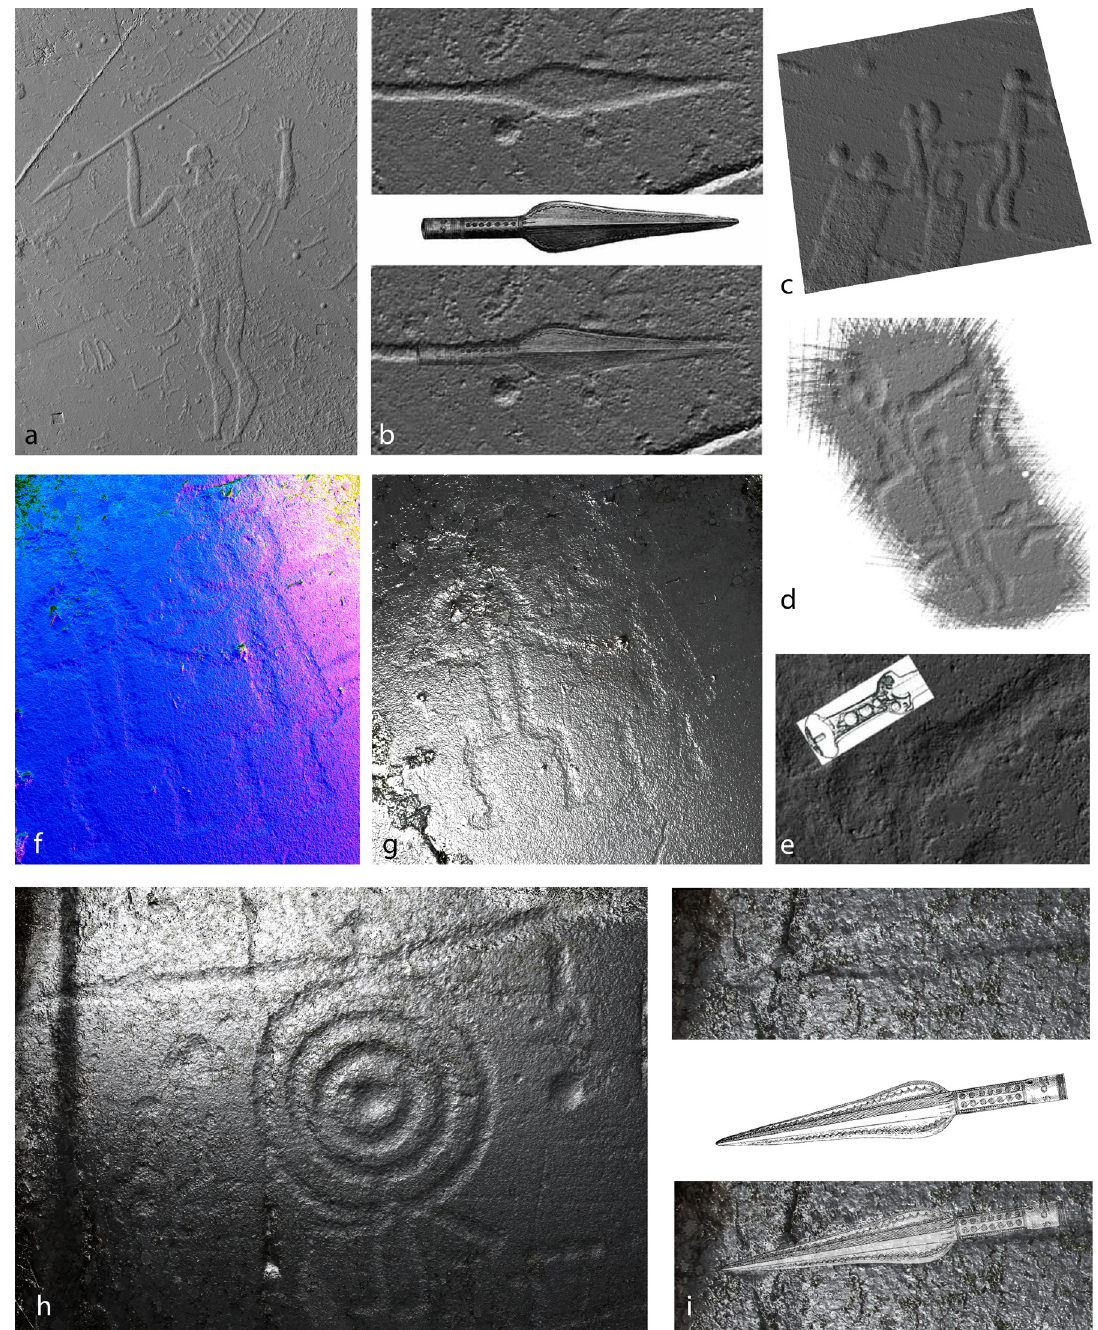
Figure 6. a. SfM of the spearman in Litsleby, RAÄ Tanum 75:1 by SHFA; b. Comparison of the spear point in Litsleby with a Valsømagle spear from Falköping (Bertilsson, 2015); c. SfM of warriors on the Fossum, RAÄ Tanum 255:1 by RP; d. Handyscan 700 scan by Länstyrelsen i Västra Götland; e. comparison with a flange hilted sword (Ling & Bertilsson, 2016); f. RTI of the two warriors with knees in Finntorp by RP & CH, normals visualized in RTIViewer and enhanced using the DStretch in ImageJ; g. RTI of the two warriors with knees, lighting adjusted to make the feet that form the knees visible on the right figure, specular enhancement filter; h. RTI of the spear man in Finntorp by RP & CH; i. Comparison of the spear point in Finntorp with a Valsø- magle spear from Falköping by